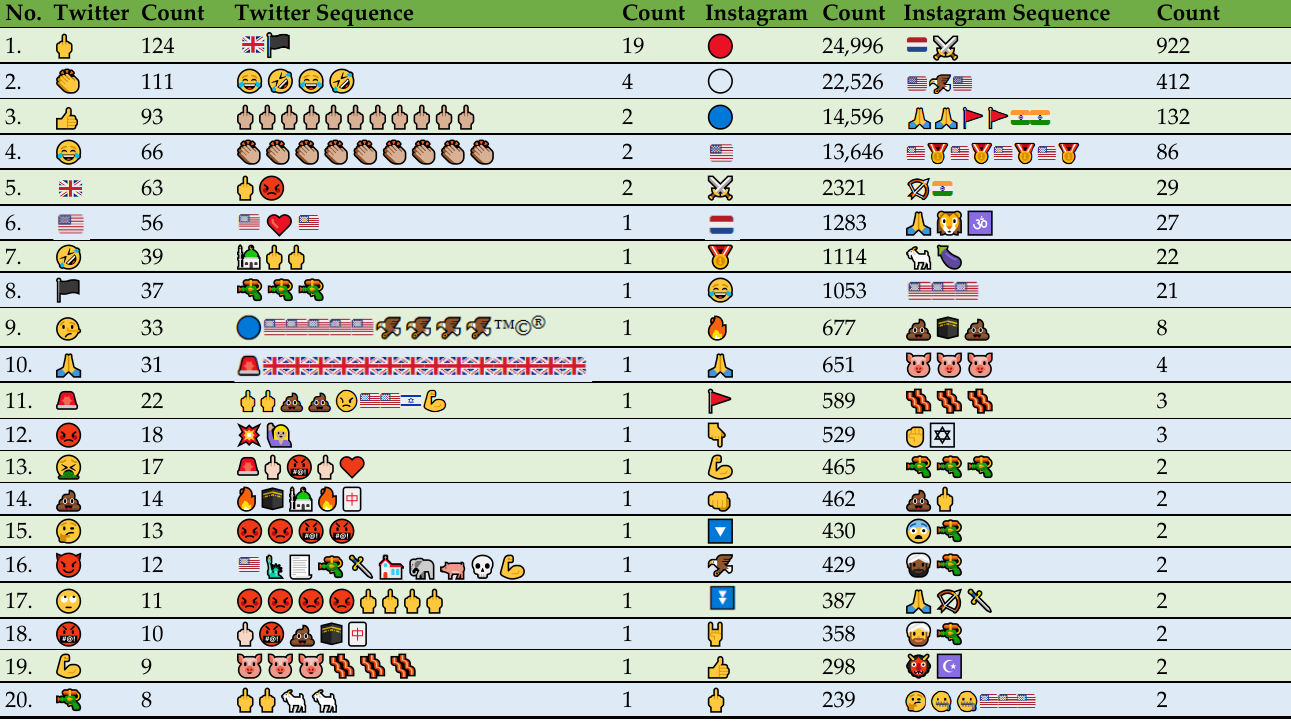
Table 3. The most frequent emojis used on Twitter and Instagram in relation to Islam. No. Twitter Count Twitter Sequence